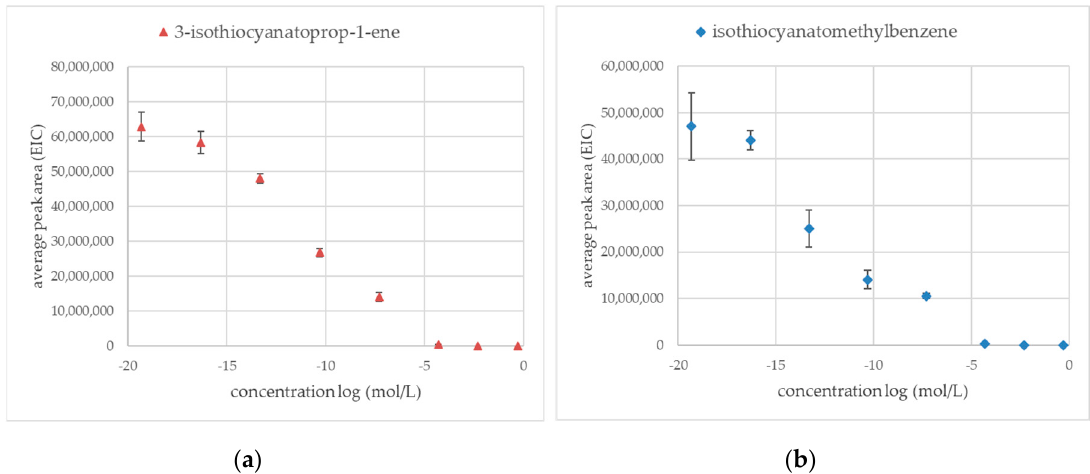
Figure 2. Area of the peaks (EIC) to the logarithm of the concentration of silver ions in the aqueous solution (mol/L); Statistical analysis: One-way ANOVA Duncan test as post-hoc ( α = 0.05); (n = 3) ( a ) 3-isothiocyanatoprop-1-ene derived from sinigrin ( m / z = 99.2); values obtained for concentration log in the range of 0 to − 5 are not significantly different ( b ) Isothiocyanatomethylbenzene derived from glucotropaeolin ( m / z = 91.2); values obtained for concentration log in the range of 0 to − 5, − 7, to − 11, and − 15 to − 20 are not significantly different.